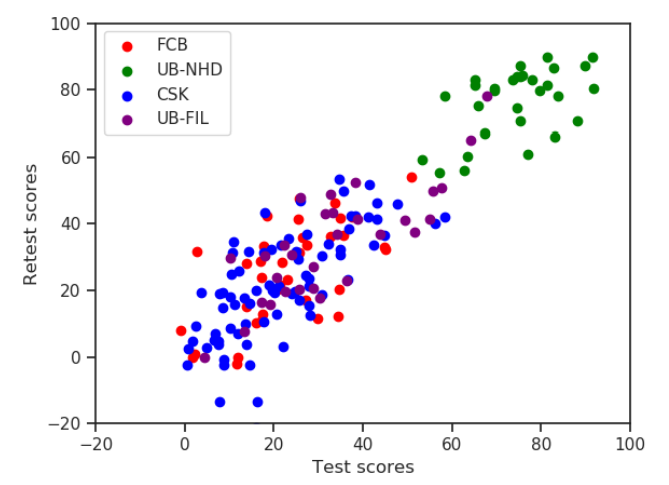
Figure 3. Scatter plot of questionnaire scores by